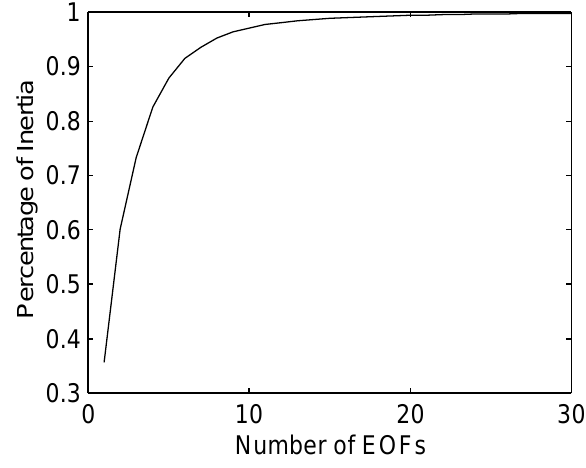
Fig. 2. Percentage of inertia versus the number of retained